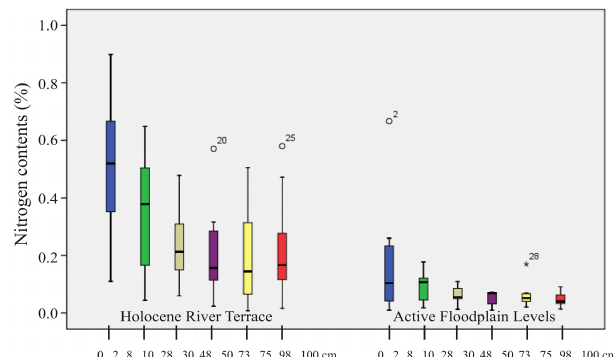
Fig. 5. Gravimetric contents of nitrogen (%) in the investigated soils layers ( i = 1–6) and geomorphic units. Central black line: median, lower/upper box end: lower/upper quartile, lower/upper horizontal bar: minimum, maximum. Outliers (values between 1.5 and 3 times the interquartile range from a quartile) are marked by circles, ex- treme values (values more than 3 times the interquartile range) by asterisks.